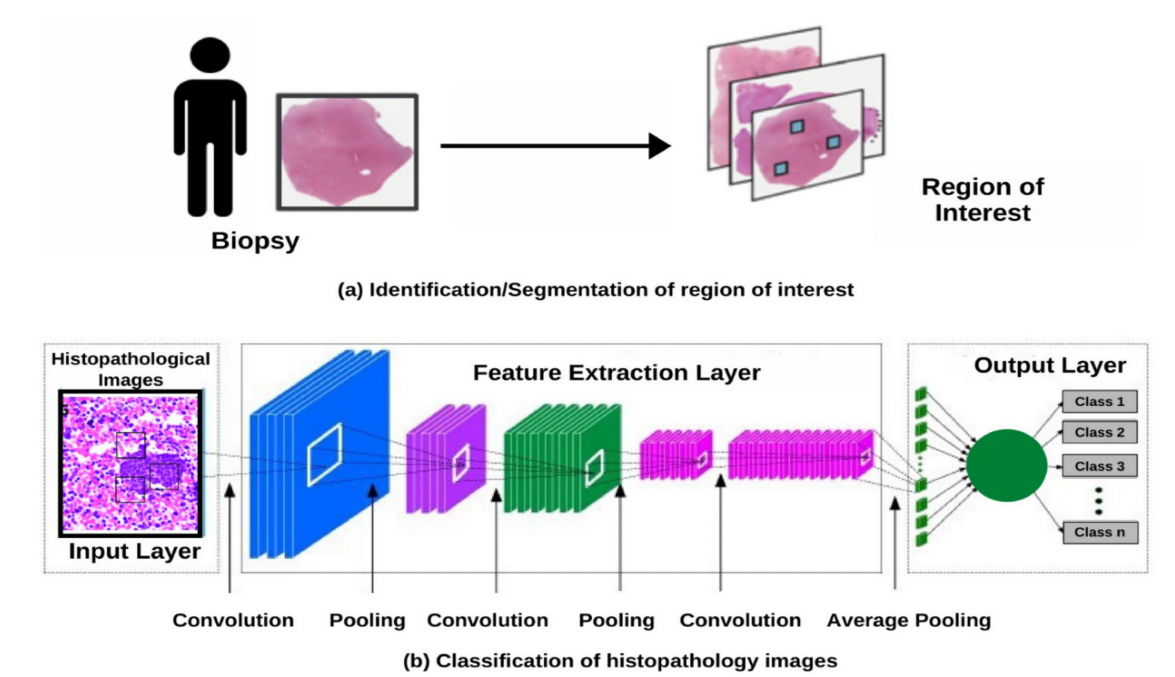
Figure 4. ( a ) Identification/Segmentation of the region of interest. ( b ) Classification of histopathological images using a deep learning